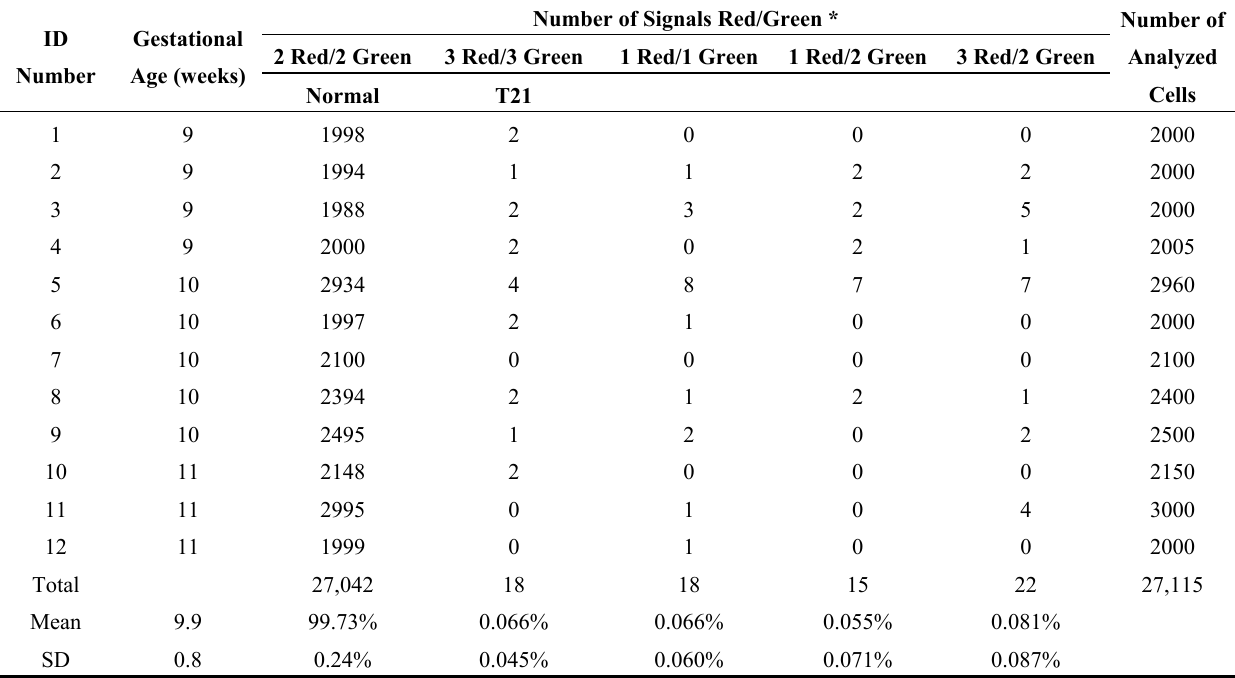
Table 1. Chromosome 21 copy number by fluorescence in situ hybridization (FISH) analysis of fetal ovarian cell nuclei. T21, trisomy